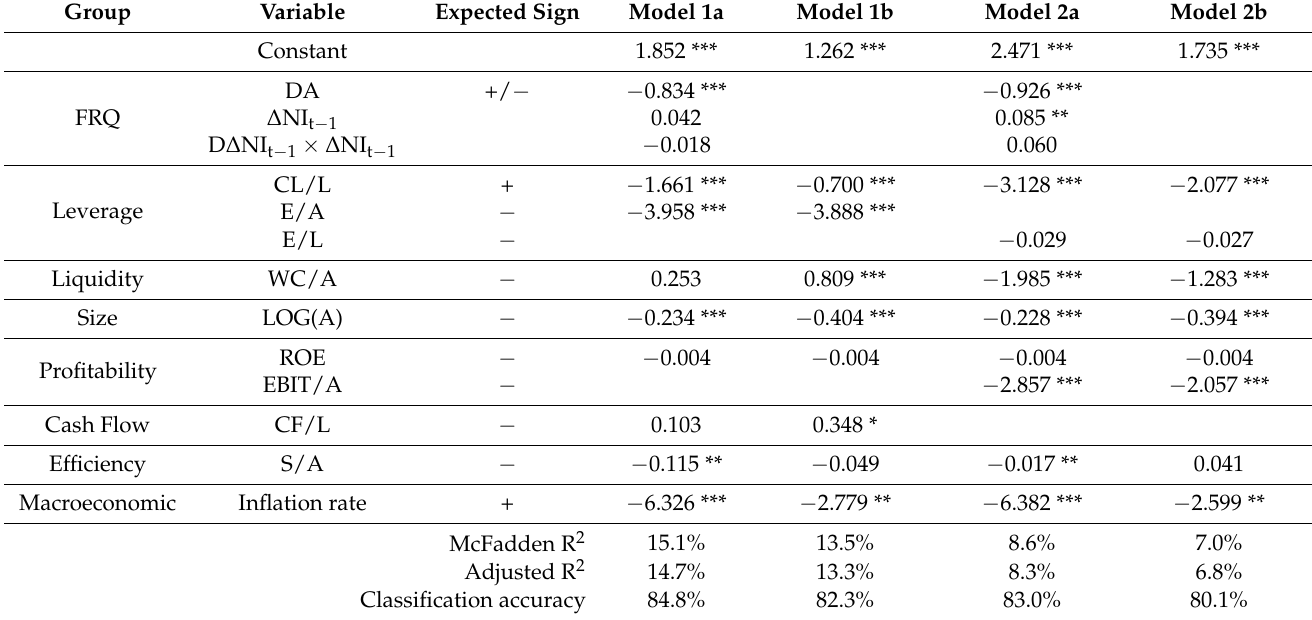
Table 4. Panel data